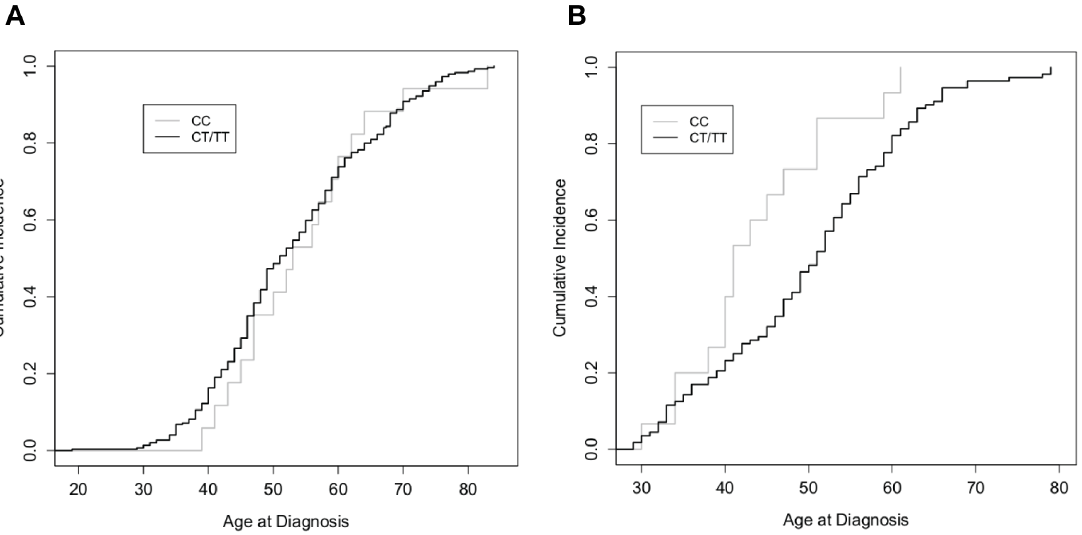
Figure 2. Cumulative incidence of breast cancer as a function of age of diagnosis for rs362962 genotypes. Fraction of individuals diagnosed with breast cancer as a function of age, in a cohort of Caucasian women diagnosed with (A) ER + /PR + ductal breast cancer and (B) ER 2 /PR- ductal breast cancer as a function of rs362962 genotype. Data were analyzed as CC (grey) versus T allele (black).